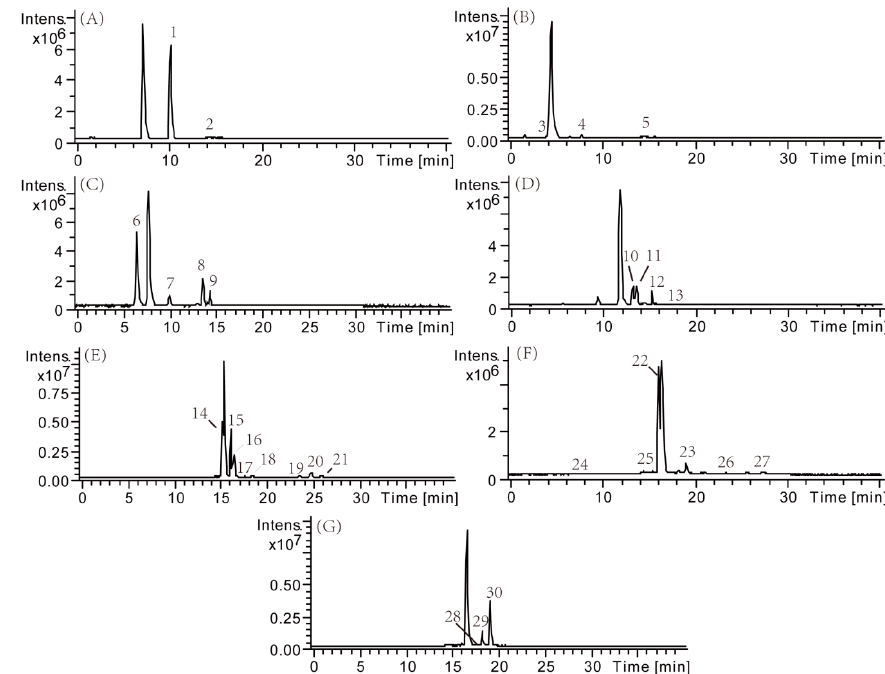
Figure 7. Total ion current chromatograms of 7 CQAs and its degradation products stored in transparent bottle at room temperature after 7 days. ( A ) 5-caffeoylquinic acid; ( B ) 3-caffeoylquinic acid; ( C ) 4-caffeoylquinic acid; ( D ) 1,3-dicaffeoylquinic acid; ( E ) 3,4-dicaffeoylquinic acid; ( F ) 3,5-dicaffeoylquinic acid; ( G ) 4,5-dicaffeoylquinic acid.